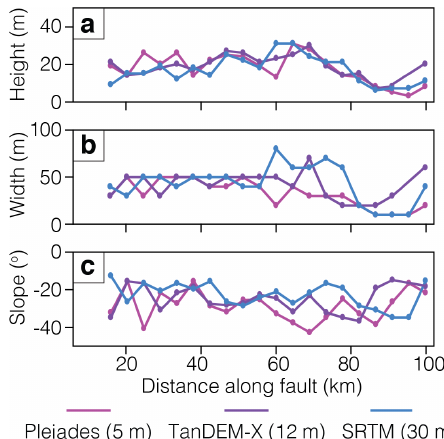
Figure 7. Manual Bilila–Mtakataka fault profile for (a) height H , (b) width W and (c) slope α taken at ∼ 5km intervals using the Pleiades 5m, TanDEM-X 12m and SRTM 30m DEMs. For tabular results, see the